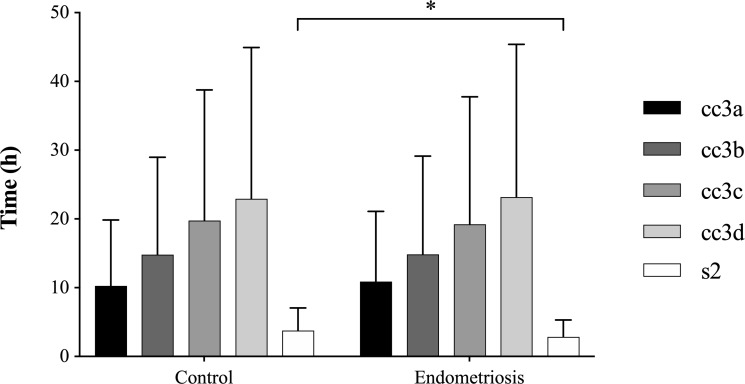
Variables of dynamic embryo development.Synchronization of cell divisions (s2) was significantly lower in the endometriosis than in the control group. Significant differences are indicated as follows: *p<0.05; Data are shown as mean values [95% CI].